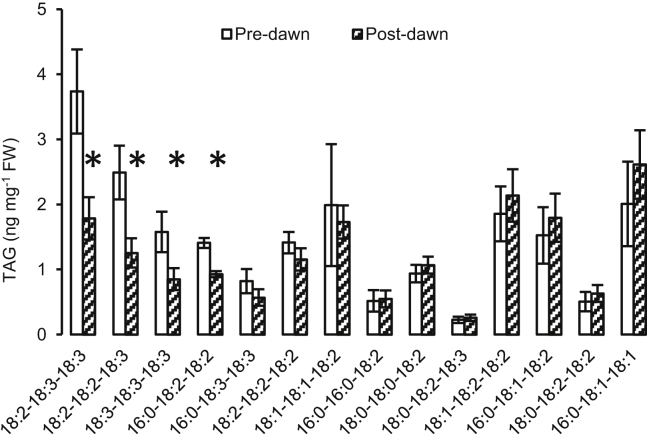
Changes in Abundance of Specific TAG Molecular Species during the Pre- to Post-dawn TransitionError bars represent ±SE; n = 13–14; significant (p < 0.05) changes are indicated by an asterisk.